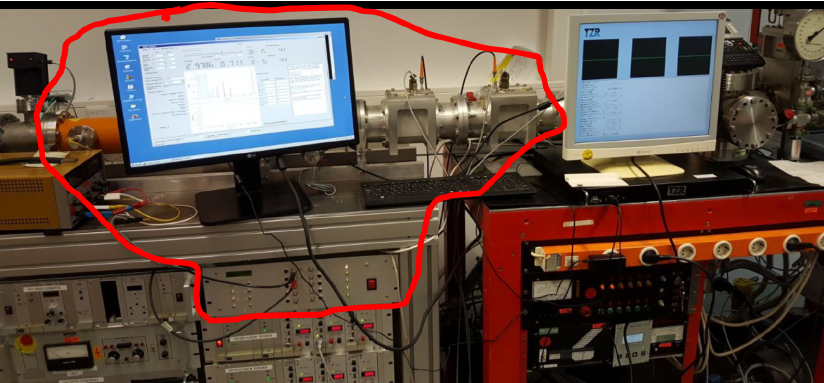
Figure 8. Small dust accelerator with the PSU system (labeled in red line). The deflection plates are contained in the yellow vacuum pipe behind the PSU